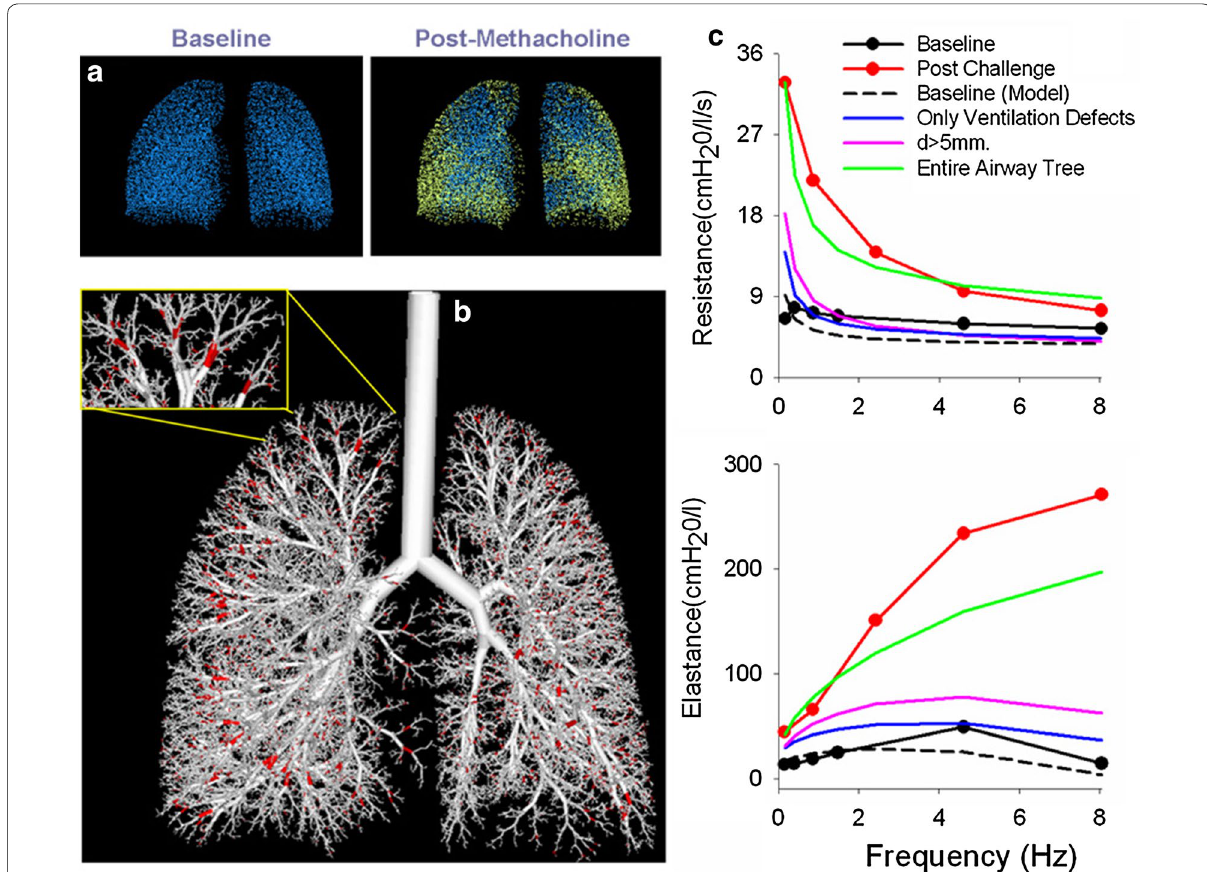
Fig. 7 Overview of image functional modeling. a Terminal units are defined from the airway tree model which are subsequently mapped to the ventilation defects obtained from HP 3 He MRI with ventilated terminal units depicted in blue and the nonventilated terminal units depicted in yellow . b Through a recursive algorithm, the largest airway is determined and designated for closure depicted in red . c Constriction patterns are applied to the airway tree model to best match measured R L and E L (reproduced with permission from